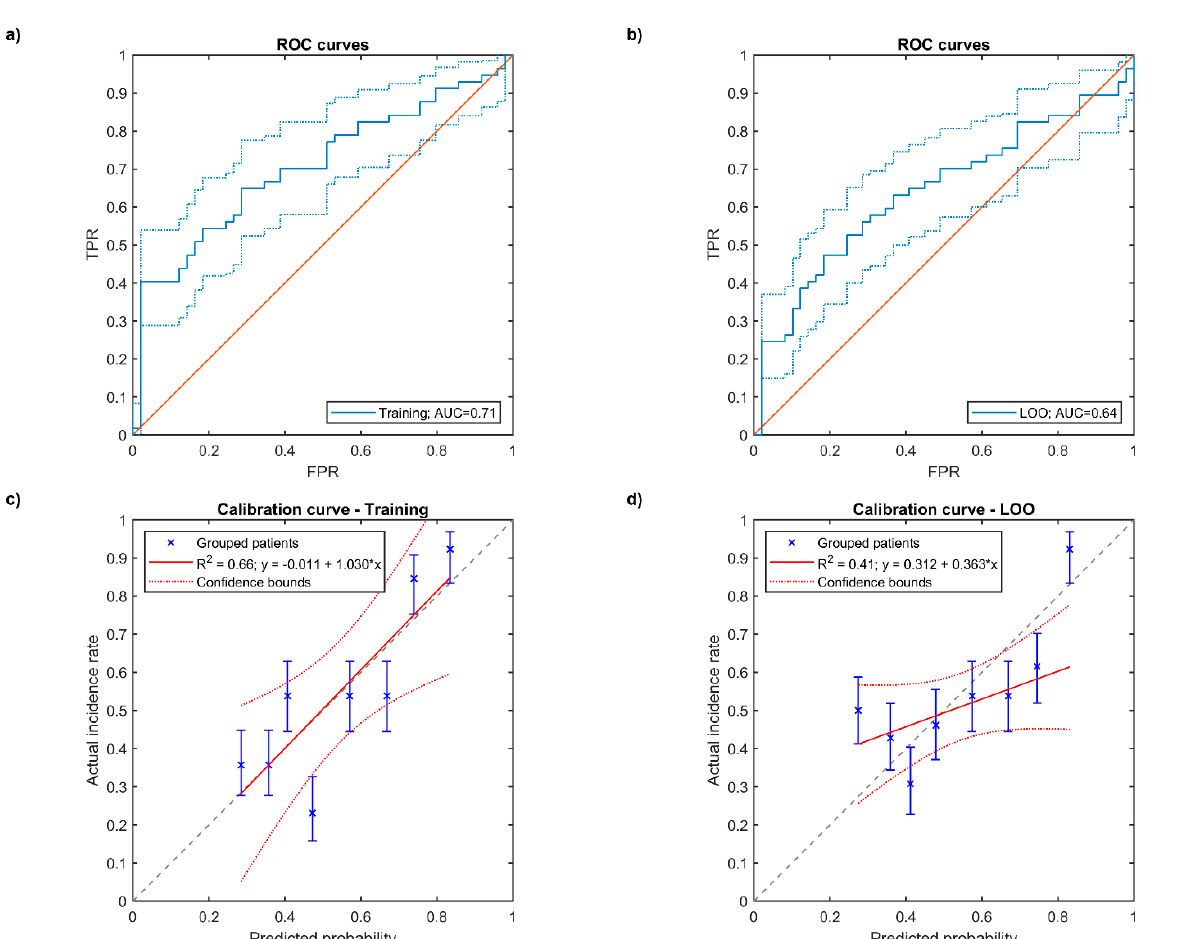
Figure 2. Training ( a ) and cross ‐ validated ( b ) ROC curves of multivariable logistic regression model (FPR: False Positive Rate, TPR: True Positive Rate), training ( c ) and cross ‐ validated ( d ) calibration plots of logistic model. In ( c ) and ( d ) the error bars for the reported values represent the 68% confidence intervals.